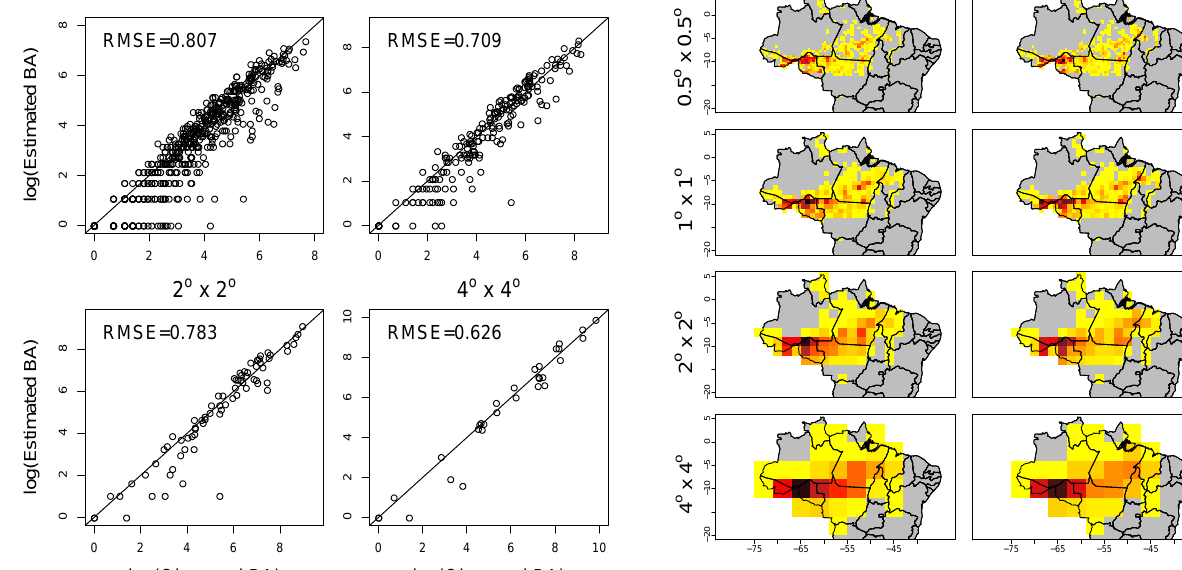
Fig. 6. Maps of burnt area estimates (left) and observations (right), in km 2 , for each